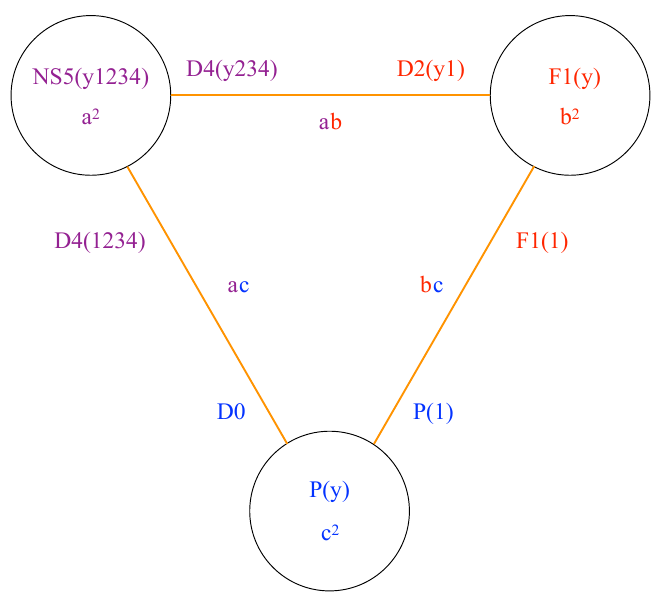
Figure 4 . Schematic representation of the three-charge NS5-F1-P bound state. The nodes represent the three charges of the bound state. Every combination of two nodes and the orange line joining them corresponds to a two-charge bound state, and the dipole charges and their coefficients in the projector are indicated next to the line.